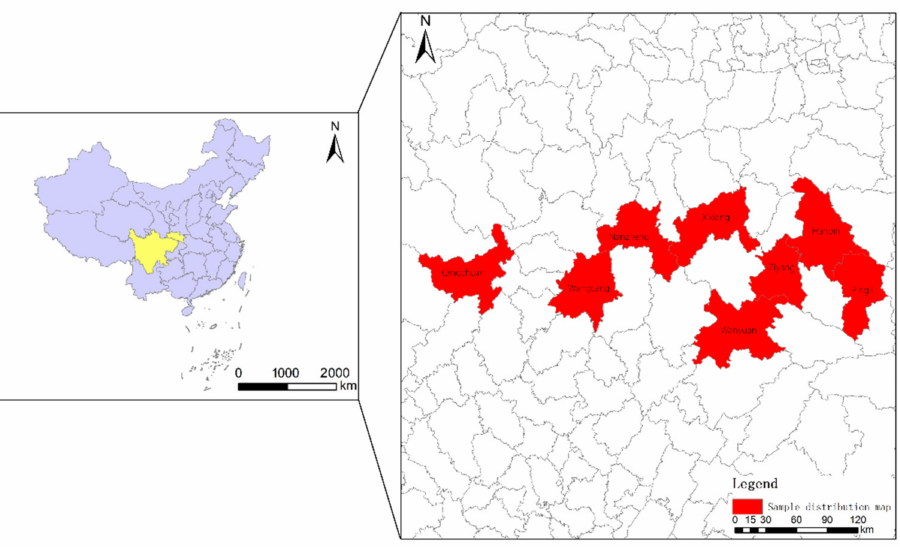
Figure 3. Sample distribution